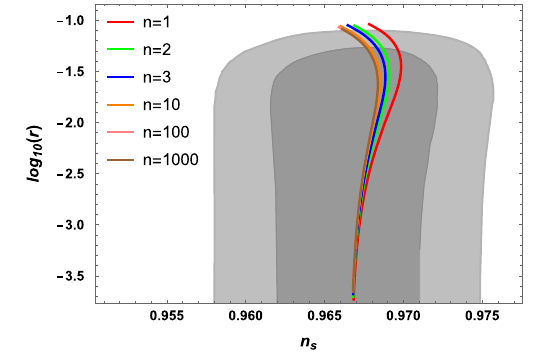
Fig. 2 The marginalized 1 σ and 2 σ confidence level contours for n s and r from Planck 2018 and BICEP2 results [19,20] and the numerical results for the α -attractor from E-models with n = 1 , 2 , 3 , 10 , 100 , 1000 in brane inflation. α is fixed to be 0 . 02 for each model